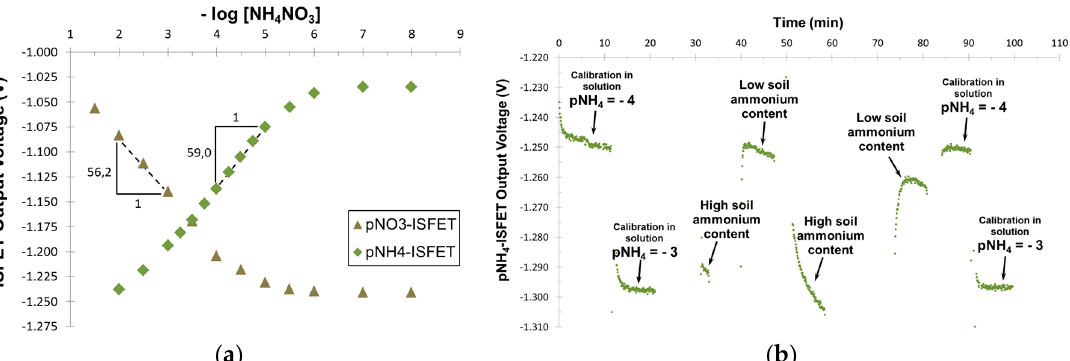
Figure 3. ( a ) Calibration curves of the pNO 3 -ISFET and pNH 4 -ISFET in aqueous solution of NH 4 NO 3 ; ( b ) Plot vs. Time of pNH 4 -ISFET signal. The measurements are first done in two calibration solutions, and then in high and low nitrogen content soils before being checked again in the two same calibration